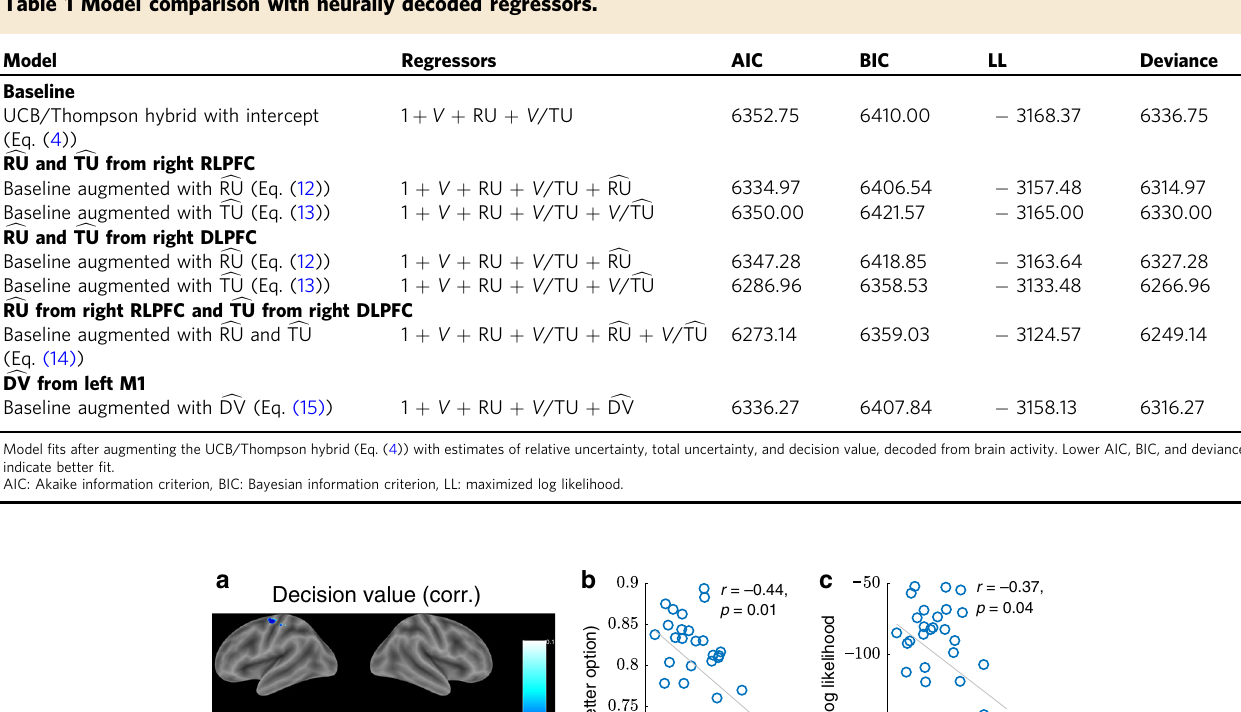
Table 1 Model comparison with neurally decoded regressors.